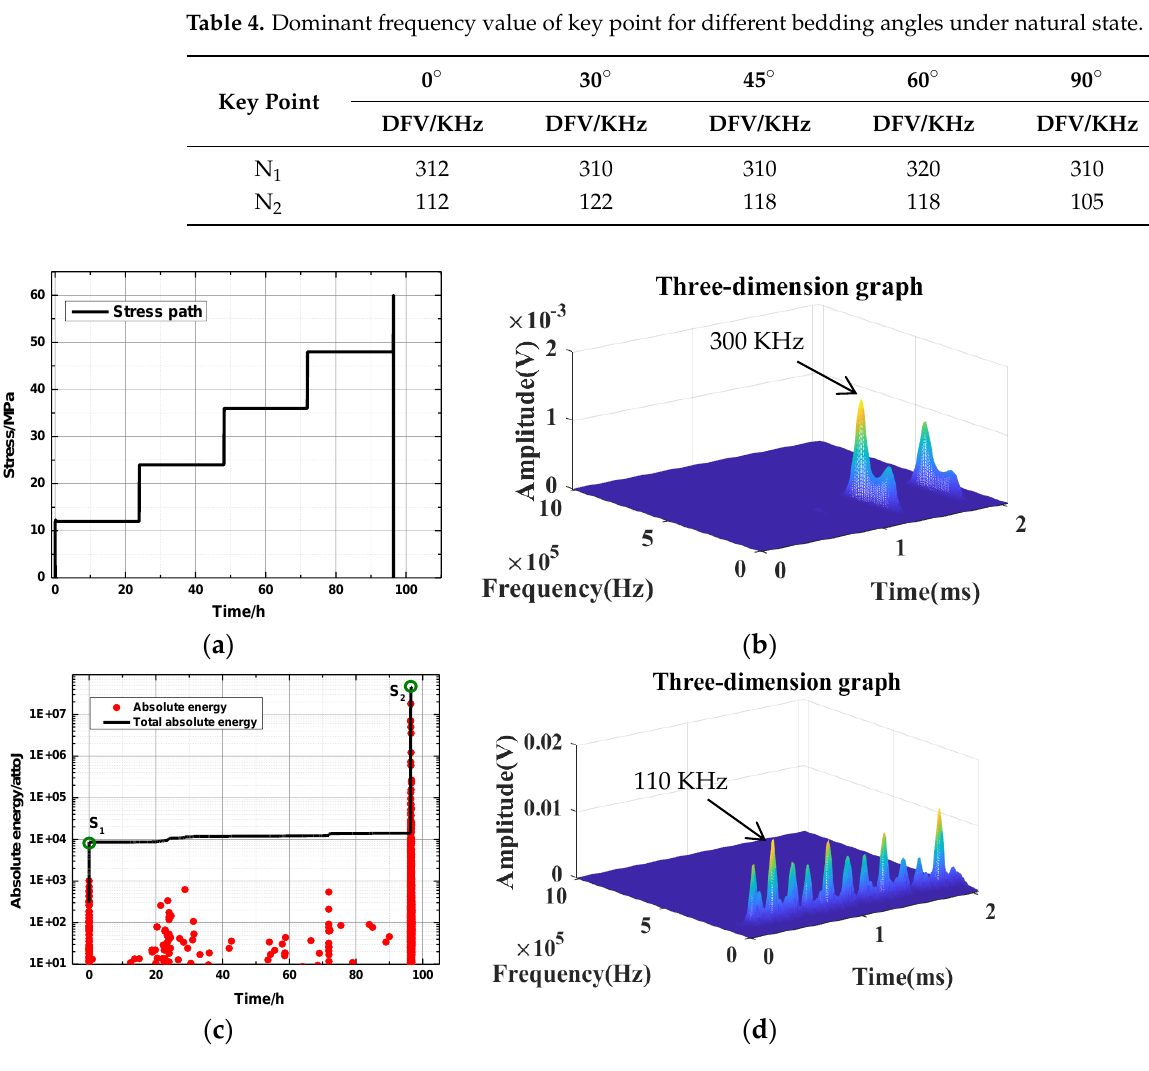
Table 6. Dominant frequency value of key point for different bedding angles under saturated state. Key Point